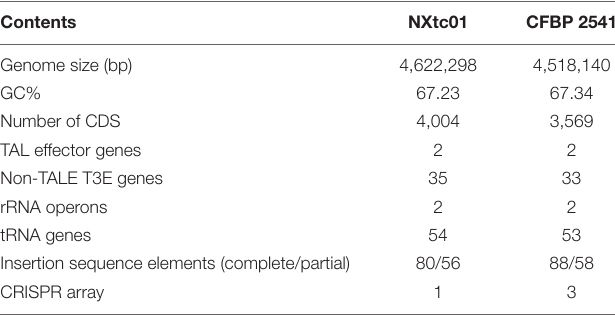
TABLE 1 | Comparison of X. translucens pv. cerealis genomes from strains NXtc01 and CFBP 2541, which were isolated from Triticum aestivum in Xinjiang, China and Bromus inermis in the United States,